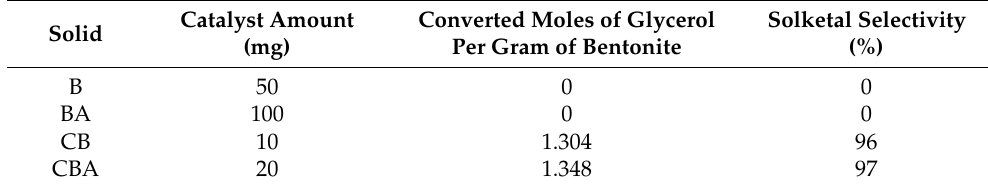
Table 3. Reaction tests for solids B, CB, BA, and CBA. Reaction conditions: T = 60 ◦ C, p = 2 MPa, t = 30 min, and acetone/glycerol molar ratio = 6:1 (A/G = 6).